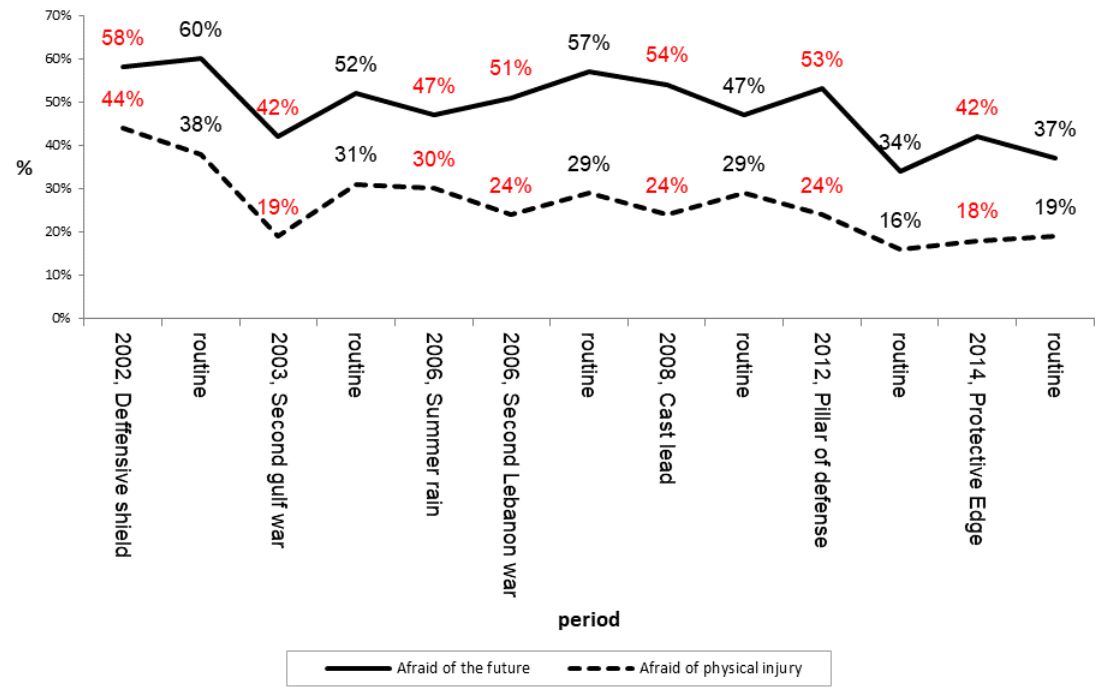
Figure 1. Percentage of respondents who answered positively during routine periods and LIC peri- ods, 2002 – 2019. Red percetage present surveys collected during Lic periods, Black percetage present surveys collected during routine